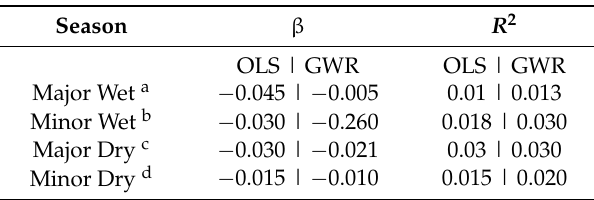
Table 3. Model validation and main results of the OLS regression and GWR models of pediatric malaria incidence (API) in